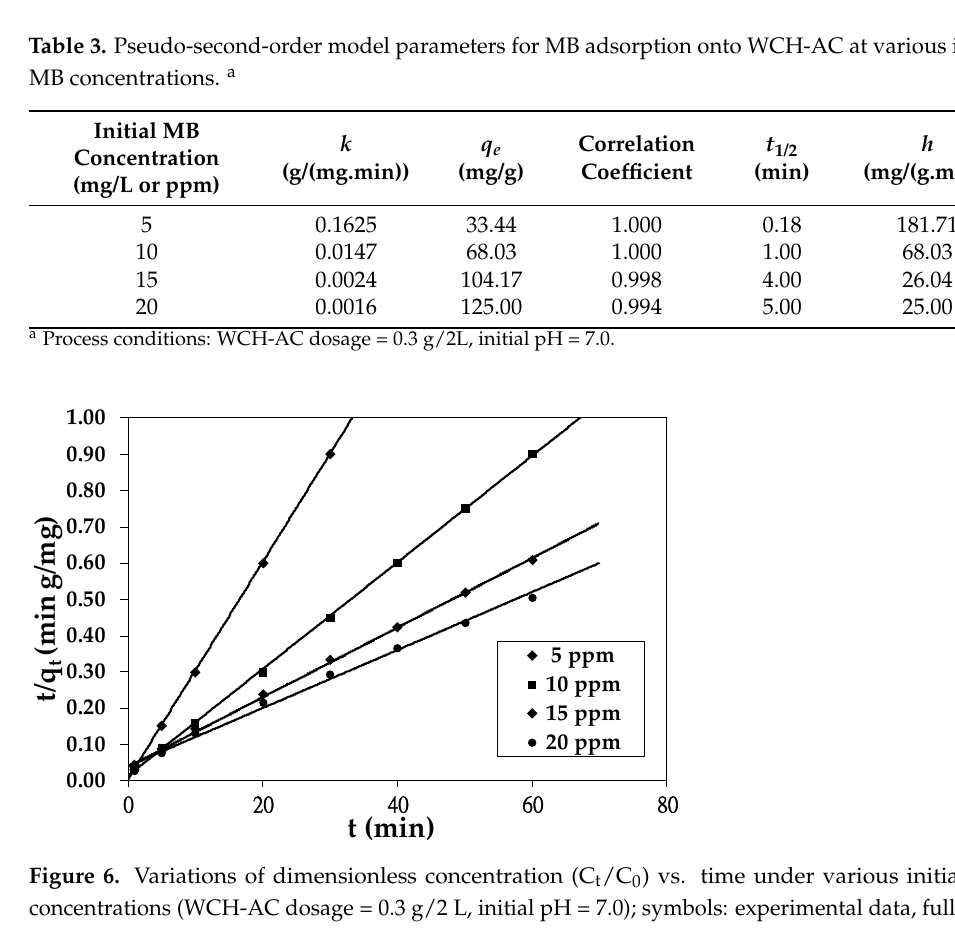
Figure 6. Variations of dimensionless concentration (C t /C 0 ) vs. time under various initial MB concentrations (WCH-AC dosage = 0.3 g/2 L, initial pH = 7.0); symbols: experimental data, full lines: obtained from the pseudo-second-order model parameters (Table 3).